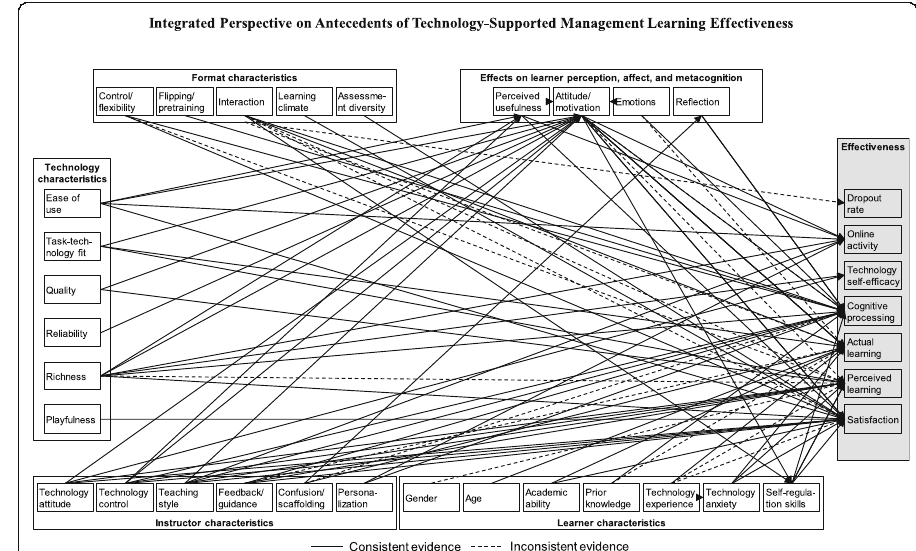
Fig. 7 Integrated Perspective on Antecedents of Technology-Supported Management Learning